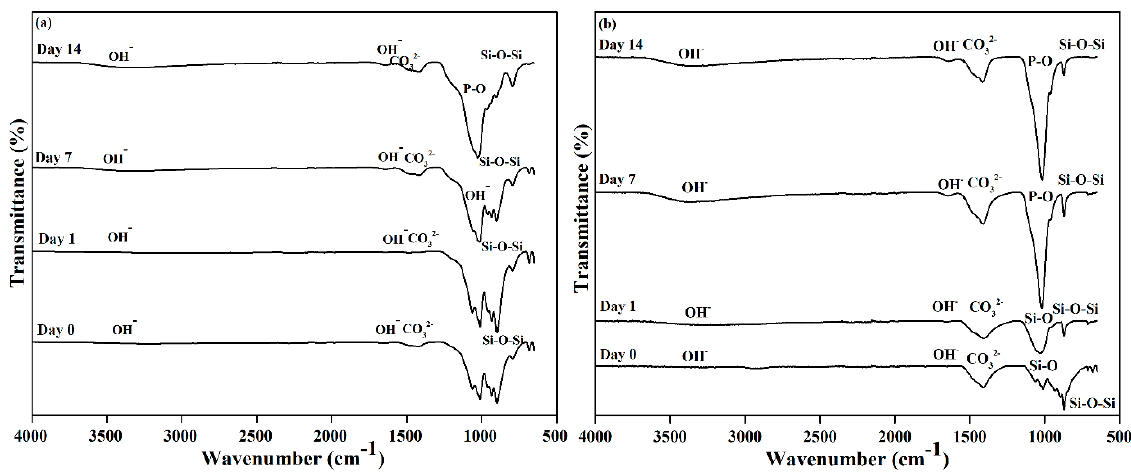
Figure 5. FTIR spectra of the ( a ) β W and ( b ) β WMAF before and after soaking in SBF from day 1 until day 14.